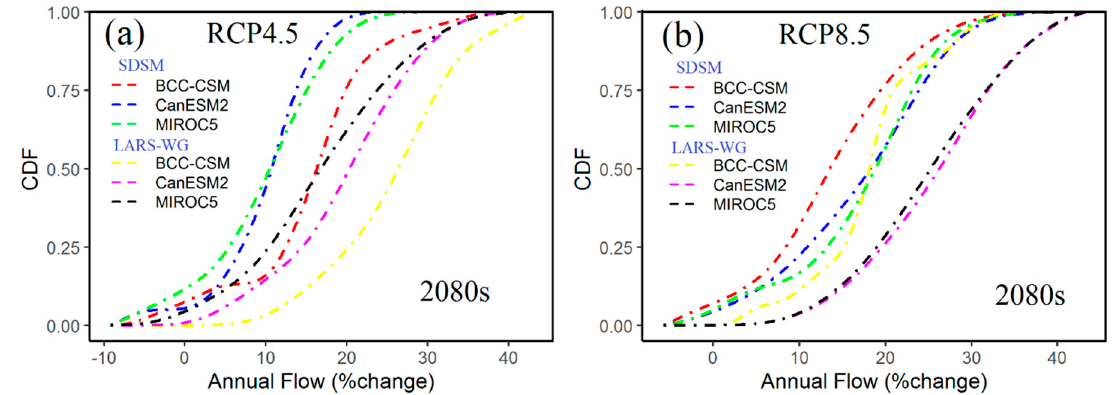
Figure 10. CDFs (Cumulative Distribution Function) of annual changes in flow under ( a ) RCP4.5, and